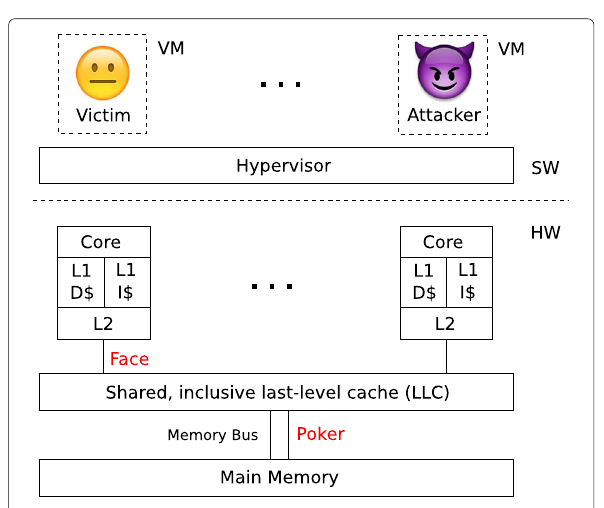
Fig. 1 System model. The figure shows the attack scenario for cross-VM attacks and the placement of Poker and Face